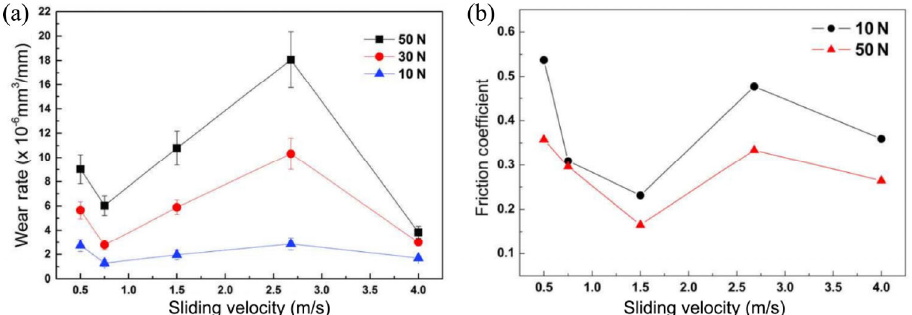
Fig. 20 Tribo-behavior of Ti64: (a) variation in wear rate with sliding velocity; (b) variation in frictional coefficient with increment in sliding velocity. Reproduced with permission from Ref. [106]. Copyright Elsevier,